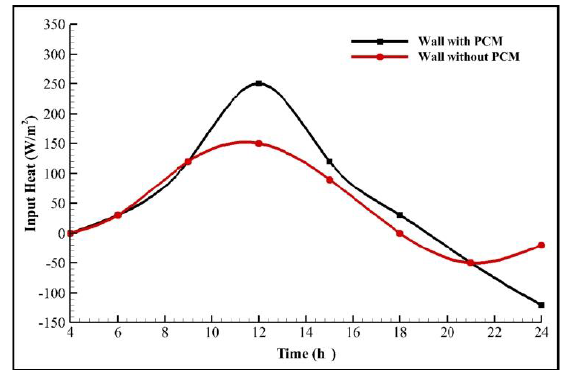
Figure 10. Heat flux through the external surface of the non ‐ PCM ‐ and PCM ‐ treated south walls.